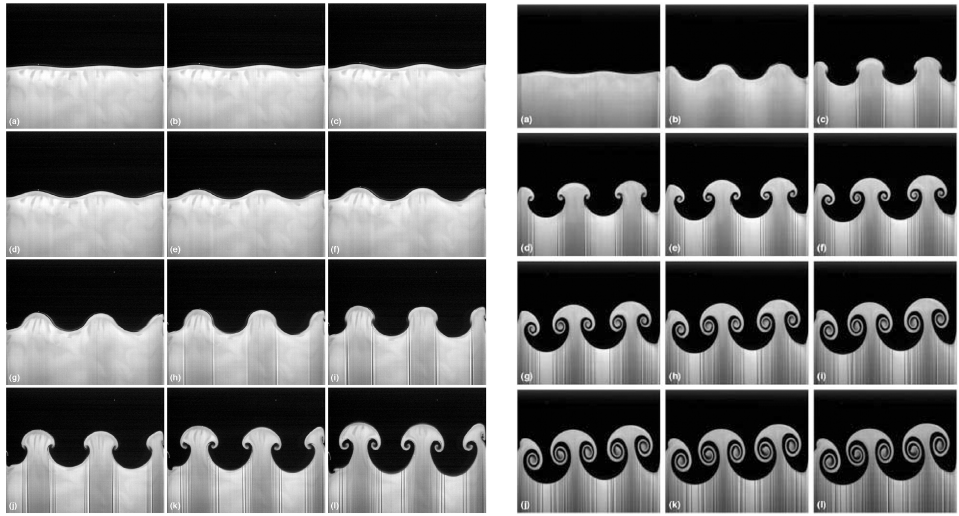
Figure 1. Difference between RTI and RMI in a sled experimental setup. ( left ) RTI, the time increment between each subsequent image is 33 ms. Reprinted from [62], with the permission of AIP Publishing. ( right ) RMI, the first image is at time before the shock is delivered, the time increment between each other subsequent image is about 83.5 ms (66 ms between the last two ones). Source [63], reproduced with permission.